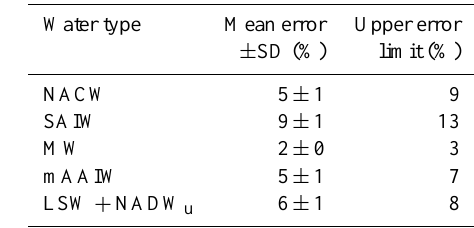
Table 3. Mean error and respective standard deviation (SD) of the results of OMP analysis regarding the sensitivity experiments. The upper error limit corresponds to the value, which is above 99% of the errors at all grid points and at all depths